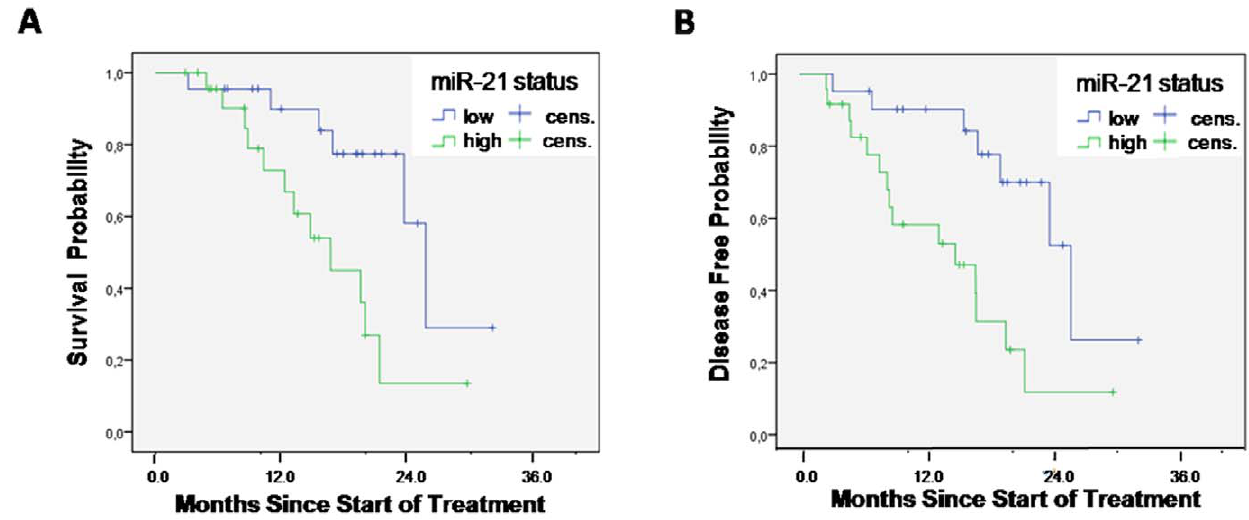
Figure 2. Survival analysis in adjuvant treated patients from the Italian cohort. (A) Overall survival according to miR-21 status and (B) disease-free survival status according to miR-21 status. Cens.: censored